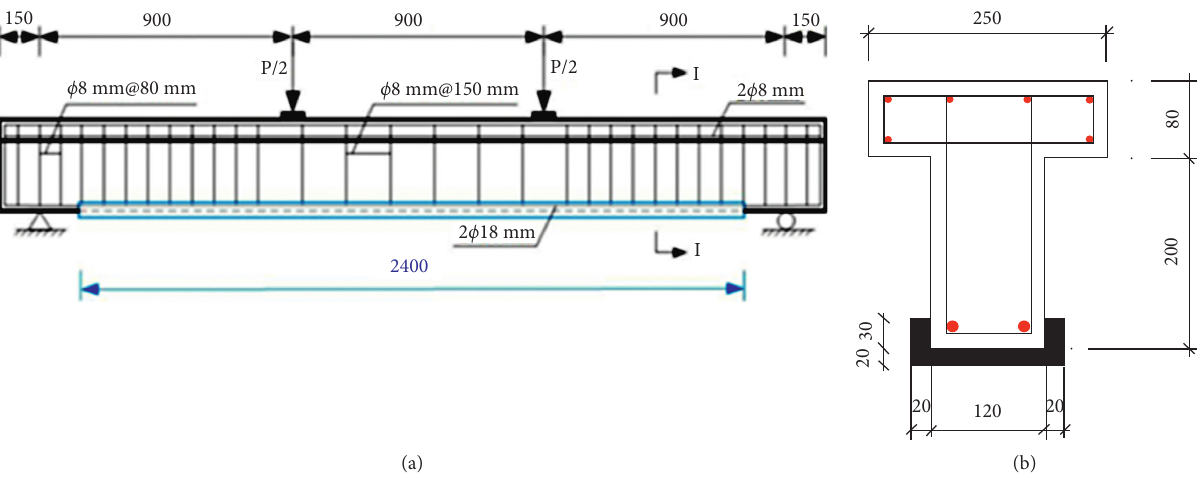
Figure 3: Section parameters of reinforced beam. (a) Longitudinal section of reinforced beam. (b) Section 1–1.